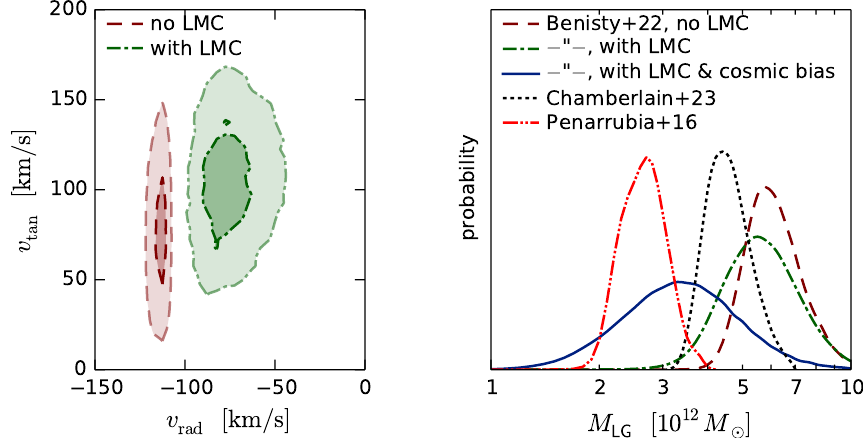
Figure 8. Left panel: relative velocity of Andromeda and Milky Way. Red contours show the measured values (using PM from [136]), green—corrected for the LMC-induced motion of the Milky Way centre. Right panel: inferred mass of the Local Group (or more correctly, Milky Way and Andromeda) from the timing argument [139]. The red dashed line is the result using the measured relative velocity, green dot-dashed line—after correcting for the LMC perturbation, blue solid—additionally multiplying by a cosmic bias correction factor. The black dotted and red dash-double-dotted lines show results of [32,140], who only account for the LMC, but not the cosmic